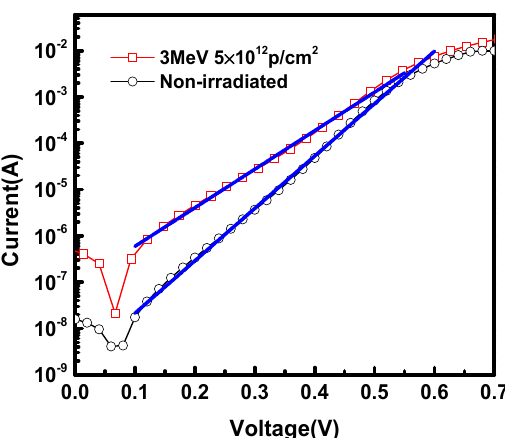
Figure 6. The semilog plot of I–V measurements without and with 3 MeV proton irradiation at the fluence of 5 × 10 12 p/cm 2 at 300 K.